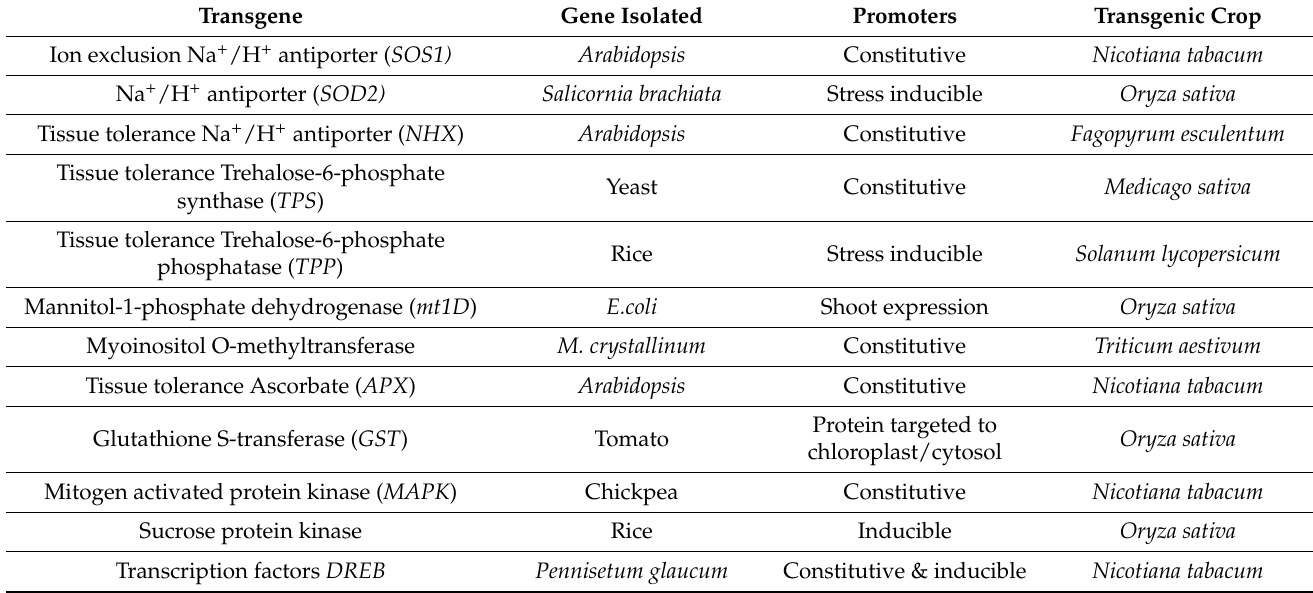
Table 4. Promoters used to improve salt tolerance traits in crop plants